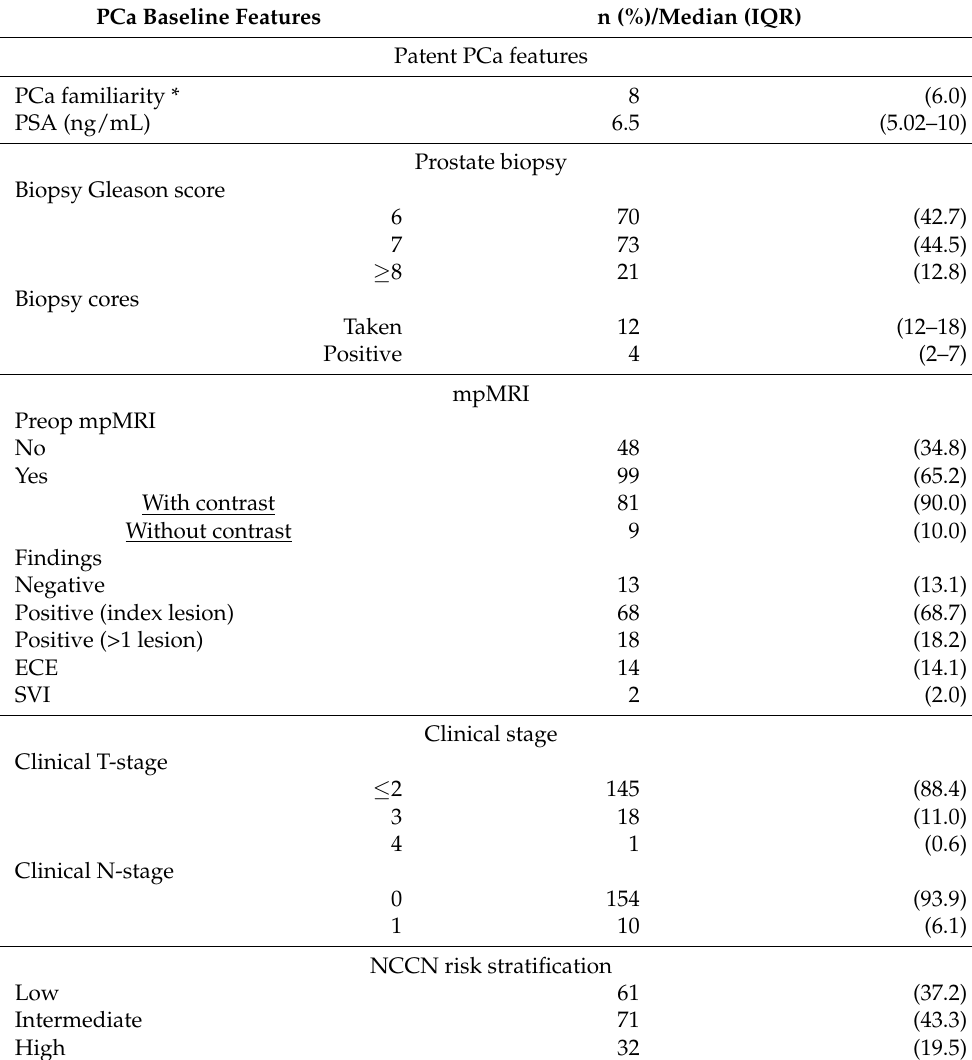
Table 2. PCa baseline